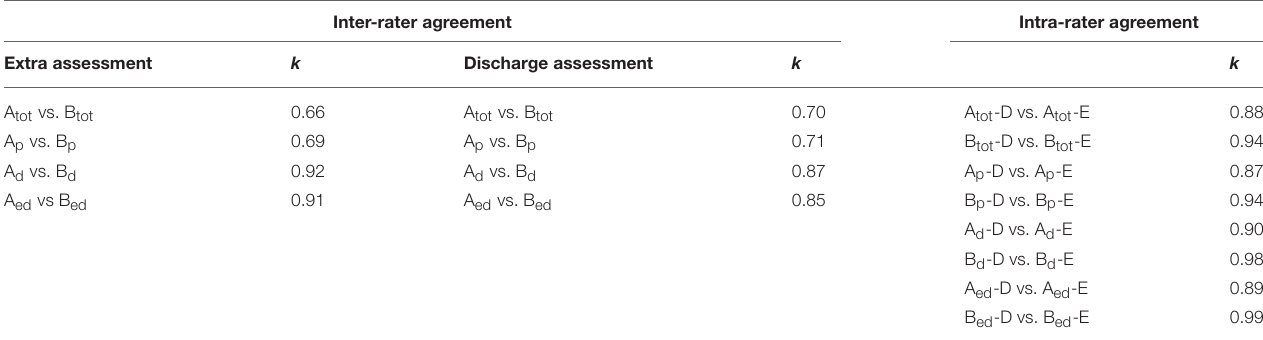
TABLE 1 | K Cohen test